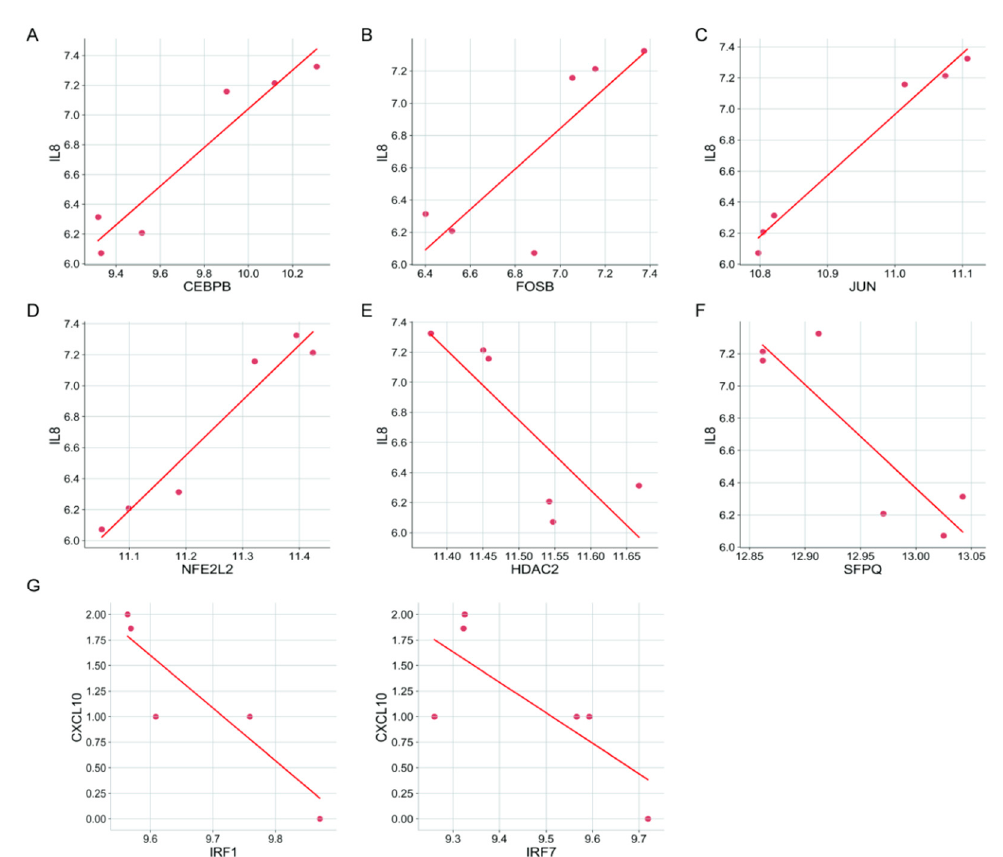
Figure 10. Correlation of CXCL8 and 10 with TFs. ( A – D ) Significant positive correlation of CXCL8 with CEBPB, FOSB, JUN, and NFE2L2. ( E , F ) Significant negative correlation of CXCL8 with HDAC2 and SFPQ. ( G ) Significant negative correlation of CXCL10 with IRF1 and IRF7.